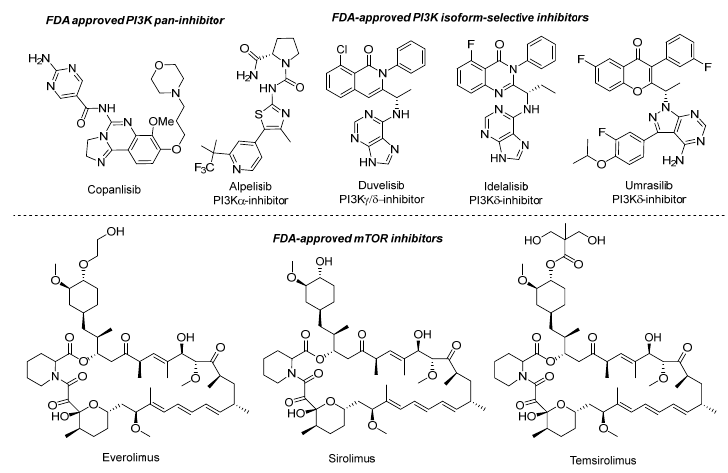
Figure 1. FDA ‐ approved inhibitors of PI3K/Akt/mTOR pathway [2,30,31]. Figure 1. FDA-approved inhibitors of PI3K/Akt/mTOR pathway